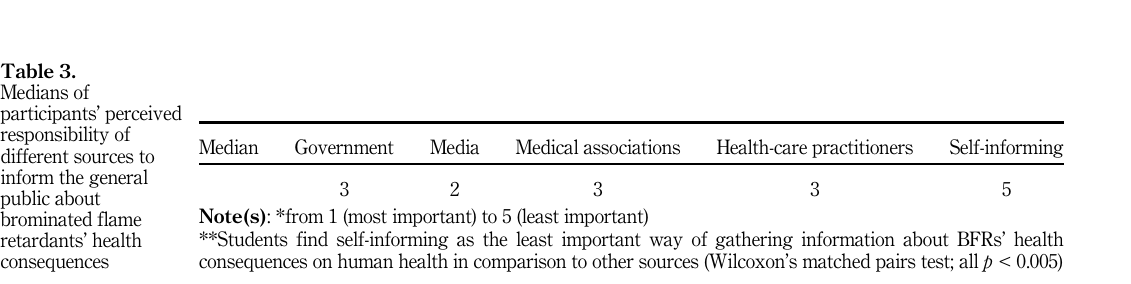
Table 2. Frequency of correct and incorrect answers per question on the knowledge test